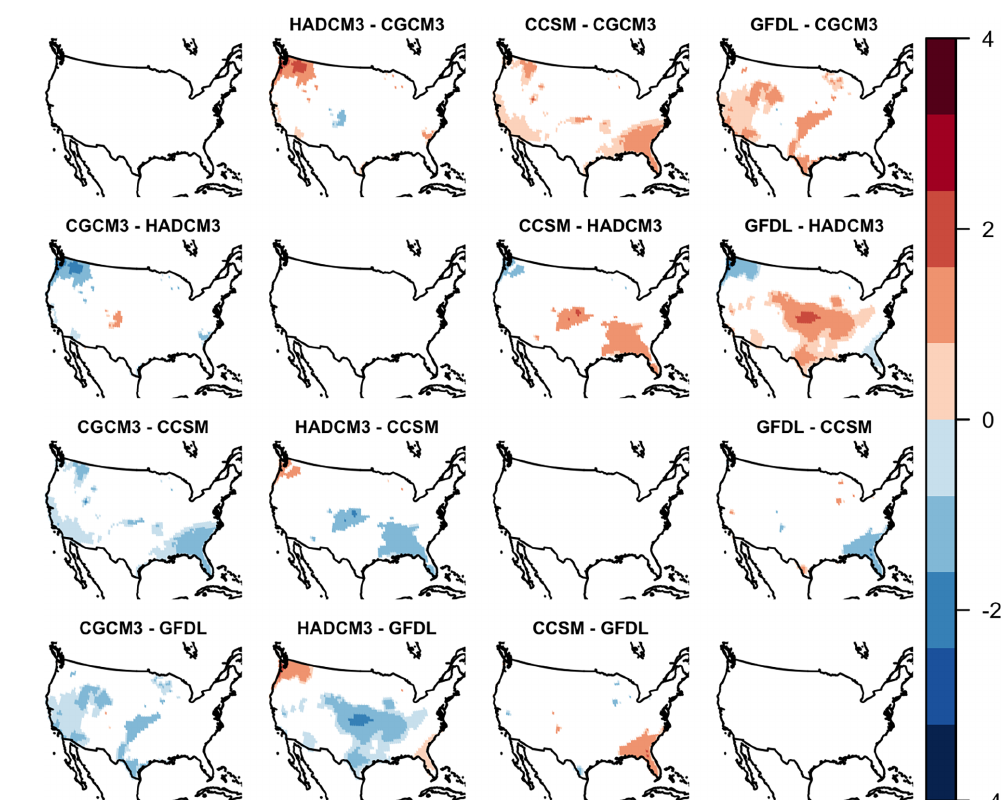
Figure 9. A heat map of the estimated average pairwise difference in GCM effect for the APL model. Only significant locations at the 0.10 level using the CoPE method are shown.